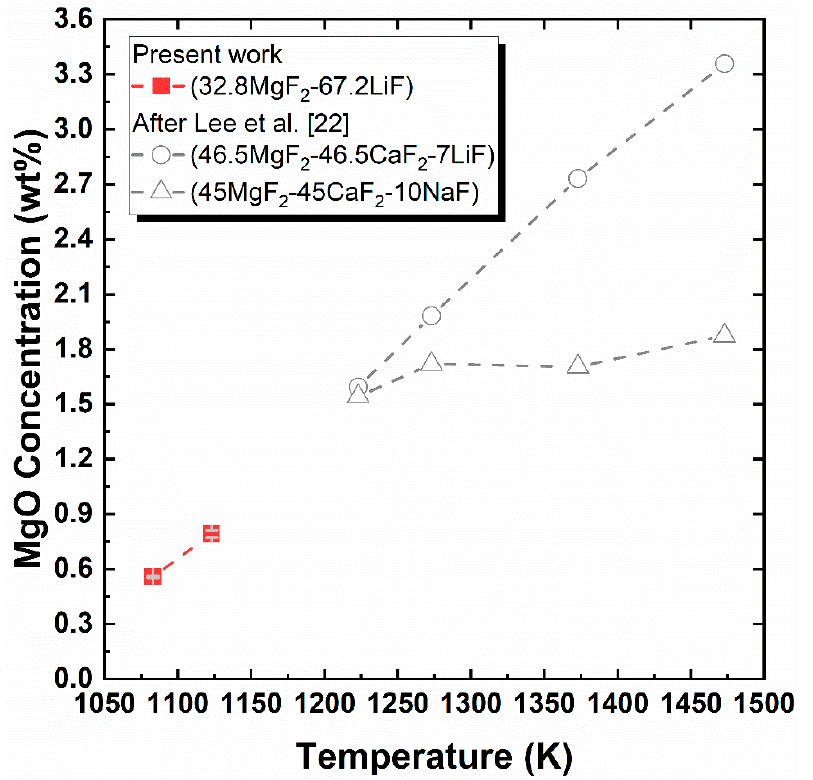
Figure 4. Relationship between temperature and MgO solubility in the 32.8MgF2–67.2LiF system and the MgF 2 –CaF 2 –(LiF or NaF) systems [22].